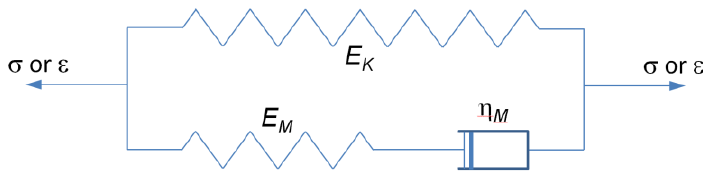
Fig. 1. Scheme of the 1D standard model of